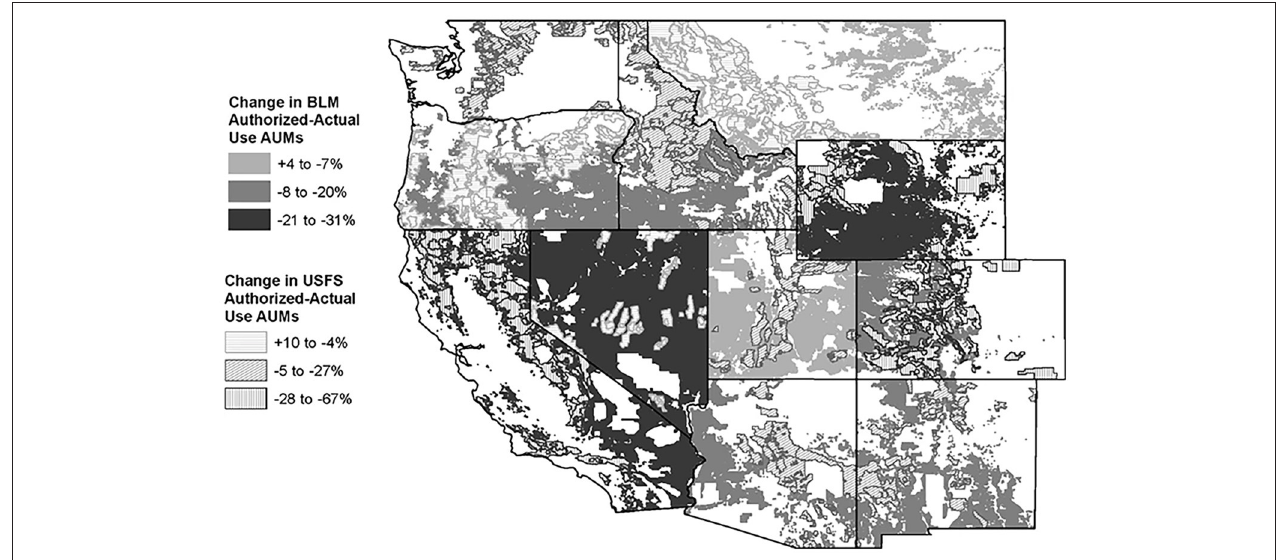
FIGURE 9 | Change in animal unit months (AUM) on public lands in 11 states in the western U.S. between 2000 and 2015. The lightest color represents slight positive to slight negative changes in AUMs. Darker colors represent increasingly negative changes in AUMs. Solid polygons represent lands administered by the Bureau of Land Management (BLM). Hatched polygons represent lands administered by the U.S. Forest Service (USFS). Data were sourced from BLM and USFS annual reports ( Oles et al., 2017).